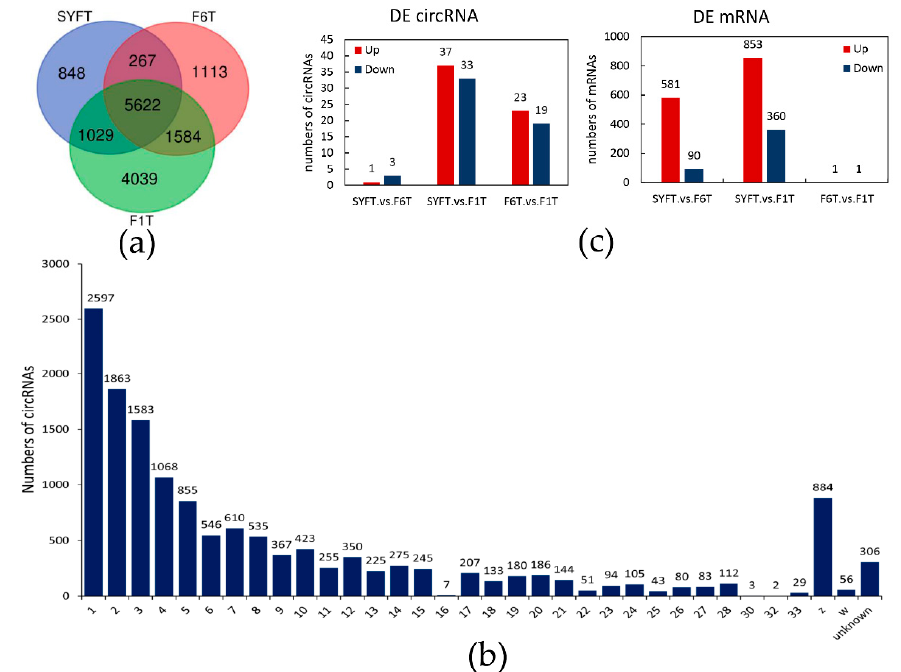
Figure 1. The novel detected circRNAs and differentially expressed analysis in theca cells: ( a ) Venn diagram of novel detected circRNAs in three types of theca cells; ( b ) distribution of circRNAs on the chromosome; and ( c ) the number of differentially expressed circRNAs and mRNAs. SYF: small yellow follicle, F6: smallest hierarchical follicle, F1: largest hierarchical follicle. T: theca cells.